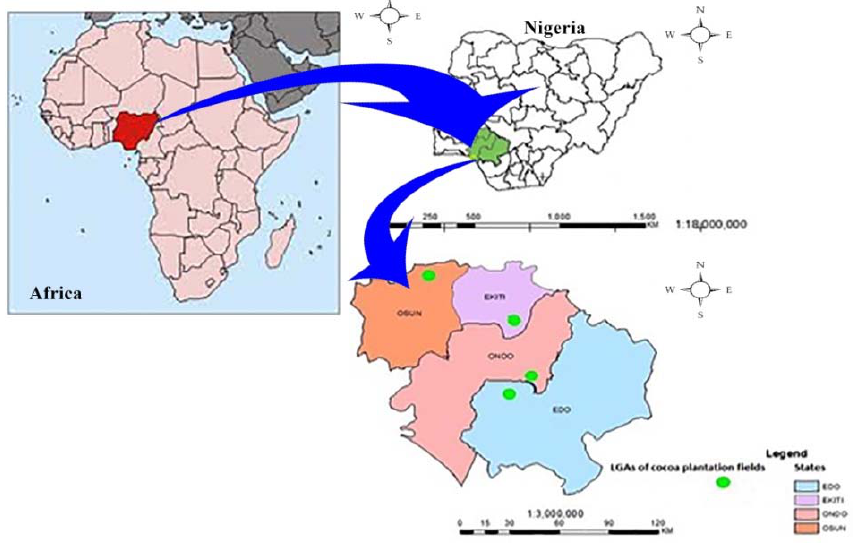
Fig. 1: Locations of the study